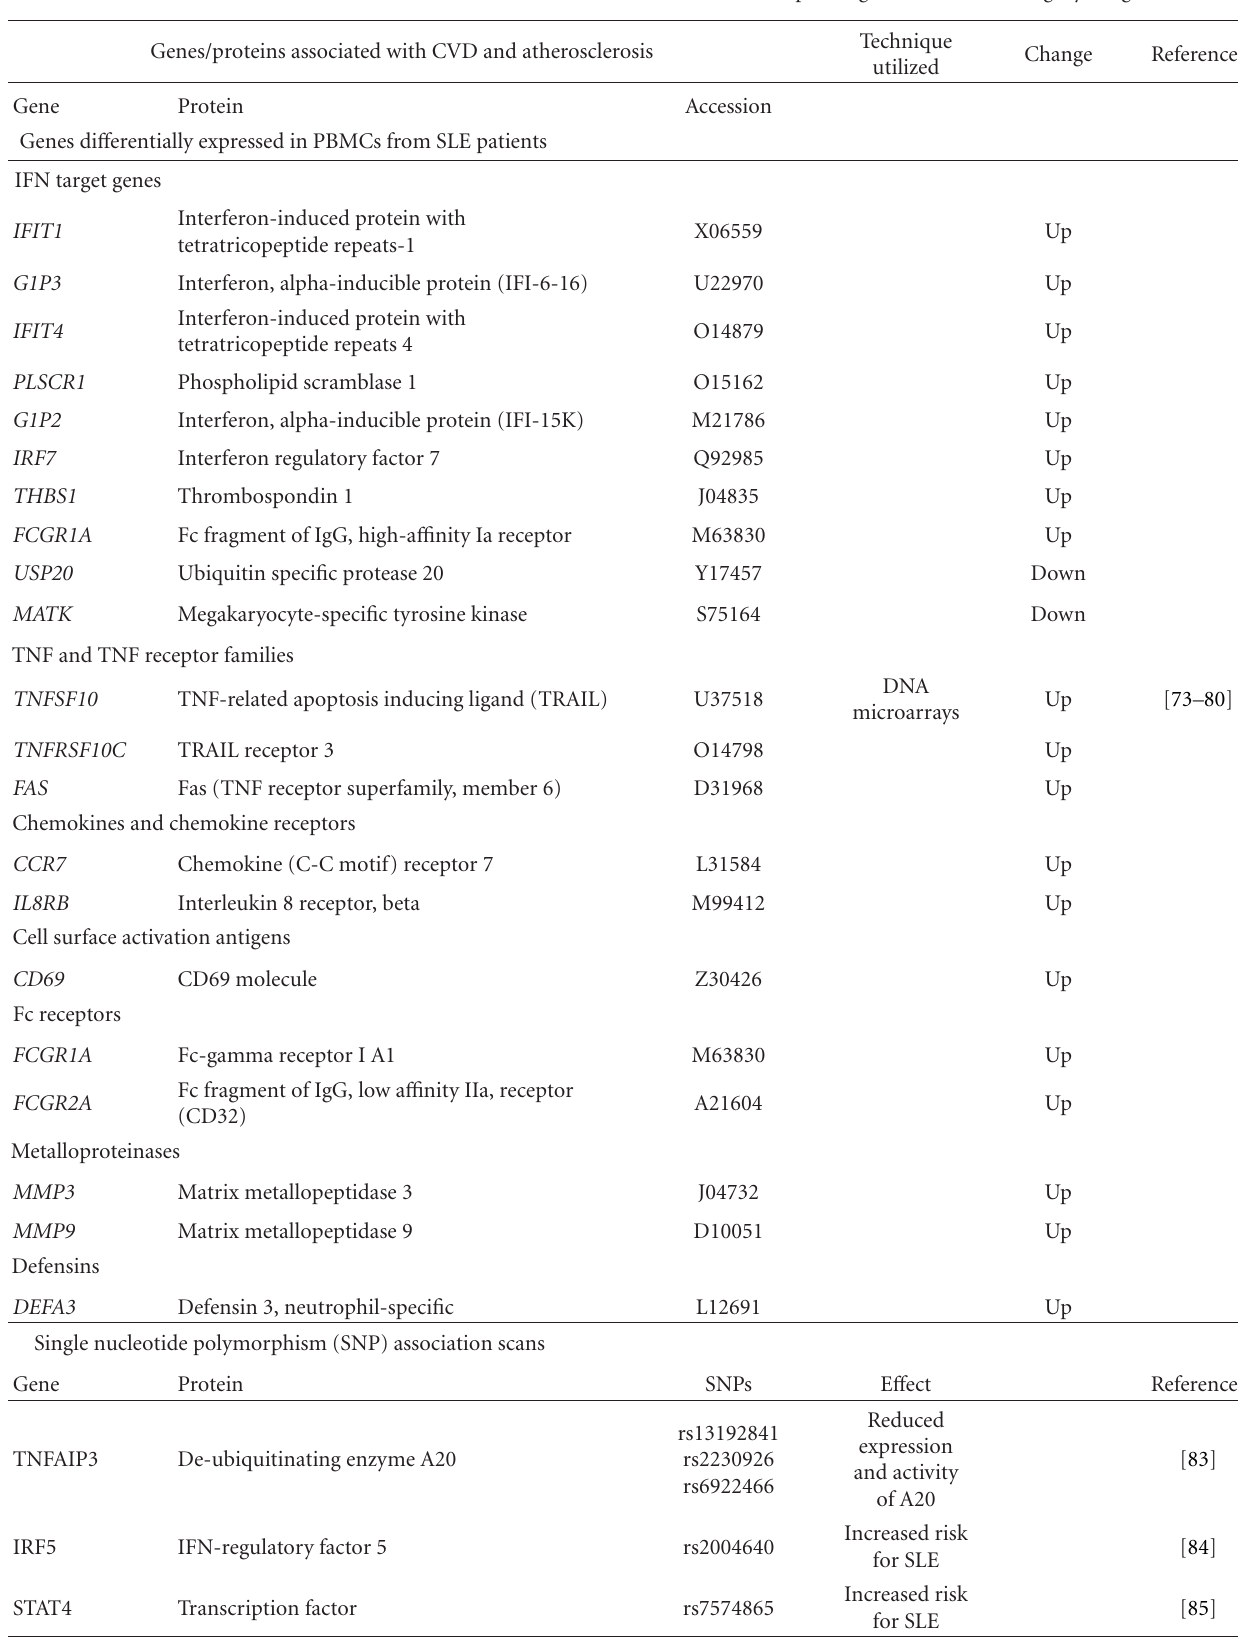
Table 1: Genomic markers of CVD risk and atherosclerosis in SLE. Some examples of genes from each category are given. Genes/proteins associated with CVD and atherosclerosis Technique